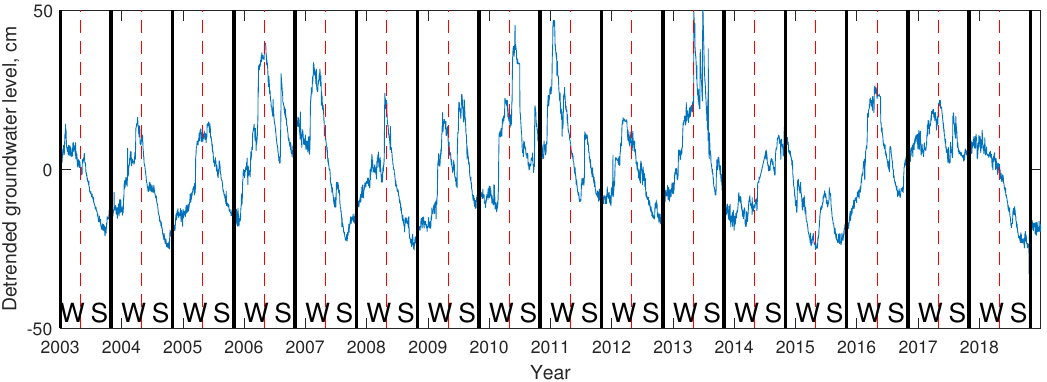
Figure 7. The detrended groundwater level fluctuation. The hydrological year is marked by the black line. Additionally, the summer/winter seasons are indicated with red broken